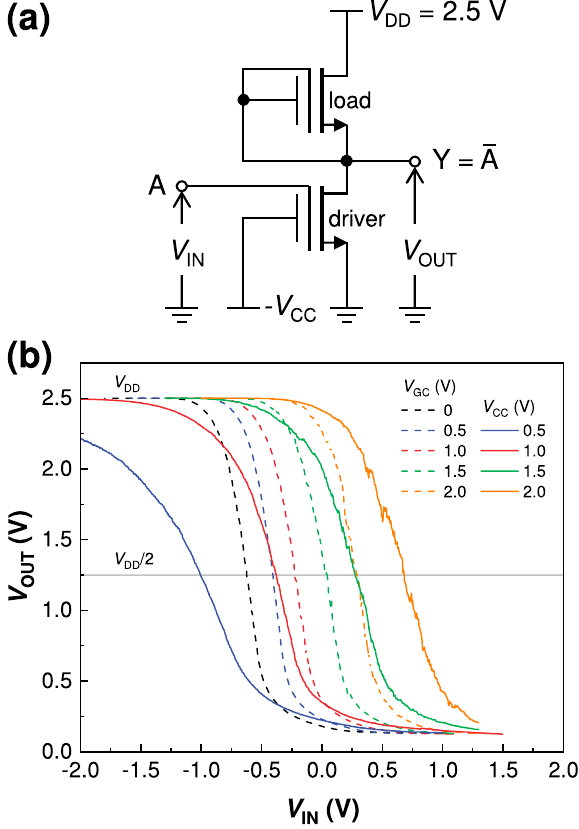
Fig. 5 A depletion-load inverter with an externally controlled switching threshold. a A schematic of a depletion-load inverter realized with two dual-gate GESFETs. The top GESFET (load) is kept in the on state by having both gates connected to the source. The bottom GESFET (driver) has the control gate connected to a negative power supply voltage − V CC so that its gate (i.e., the input voltage V IN ) is always at the higher potential. This shifts the threshold voltage of the driver to positive values if V CC is suf fi ciently large. b The static voltage transfer characteristics of the inverter for different V GC (the inverter shown in Supplementary Fig. 11) and V CC (the present inverter). The switching threshold V M of the inverter is the input voltage at which V OUT = V DD /2. Logic 0 at the input corresponds to V IN < V M and logic 1 to V IN > V M . The corresponding voltage gain is shown in Supplementary Fig. 12.